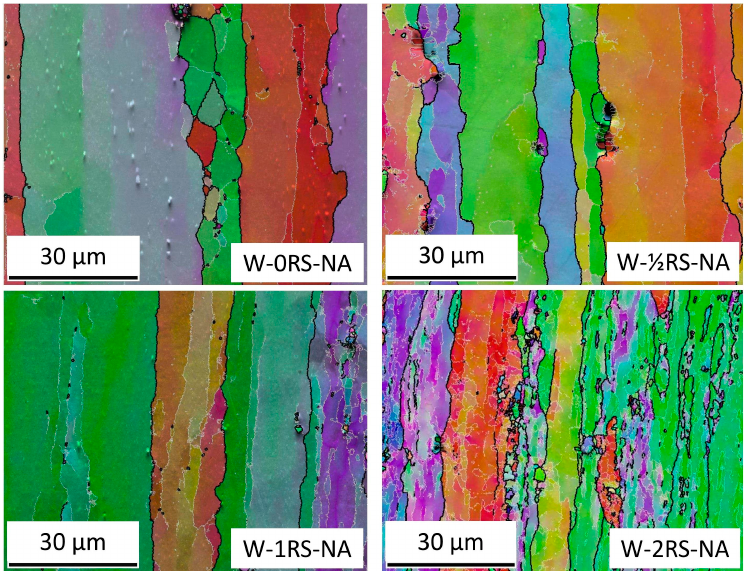
Figure 7. EBSD images where HAGB are shown in black and LAGB in white.